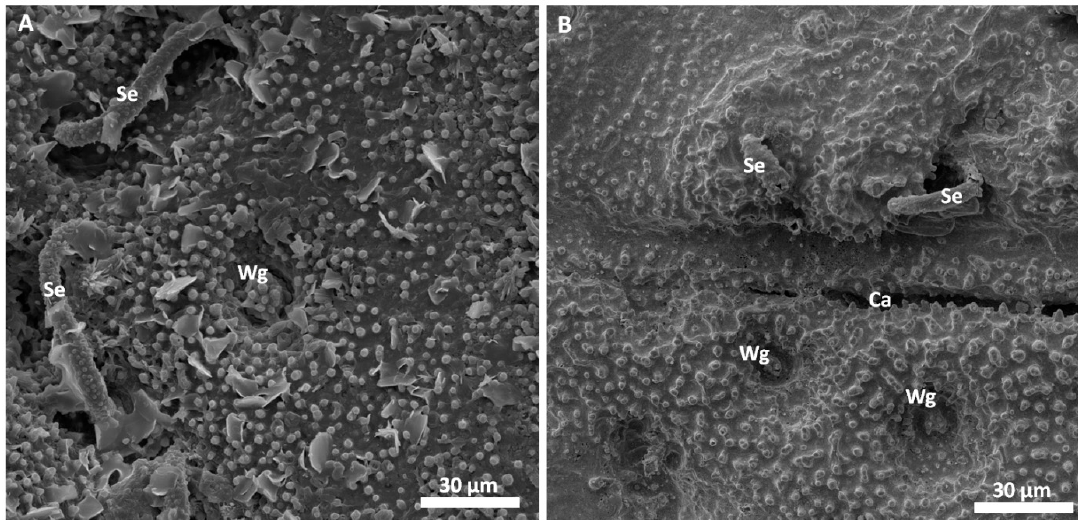
Figure 6. Comparison between ( A ) the original surface of a sputter coated specimen of D. lunatus and ( B ) an all-metal replica. The SEM images depict how well the all-metal surface replicates the natural counterpart. All relevant features are copied in detail: wax glands (Wg) and setae (Se), and surface microstructure. Crevasses of intersegmental capillaries (Ca) can also be replicated to a certain degree.